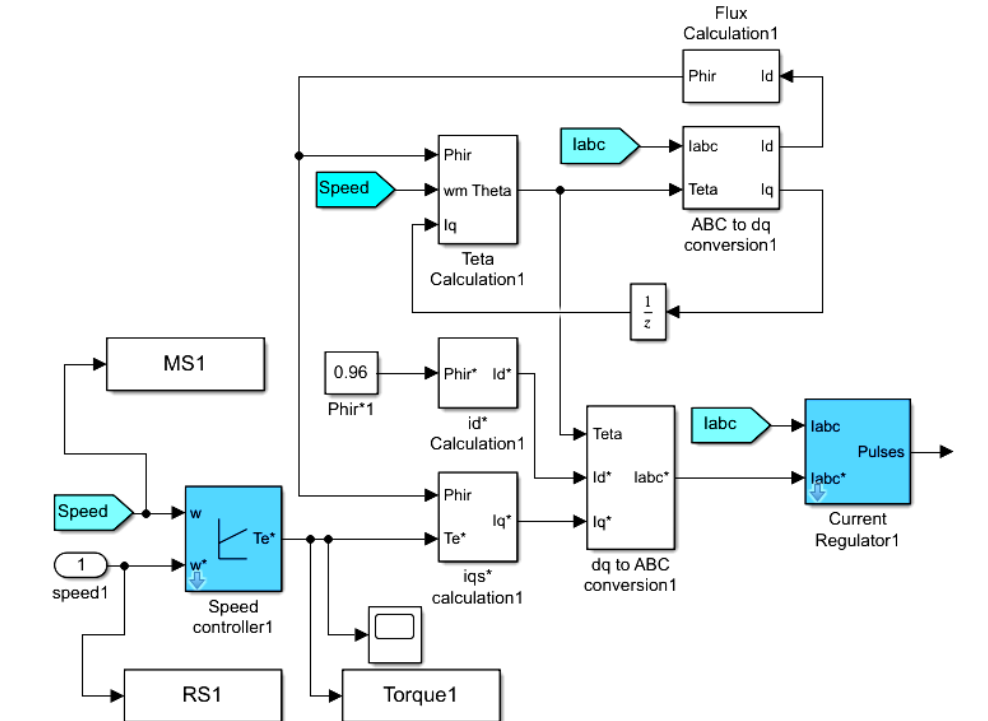
Figure 4. Simulink model of P–I control–based speed controller.